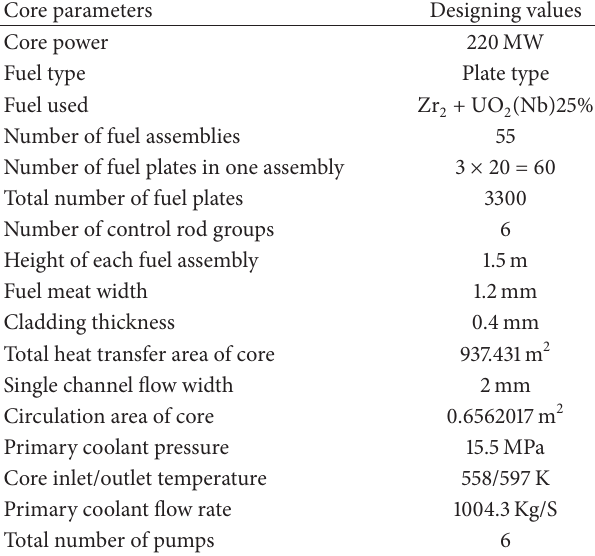
Table 1: Design parameter of reactor